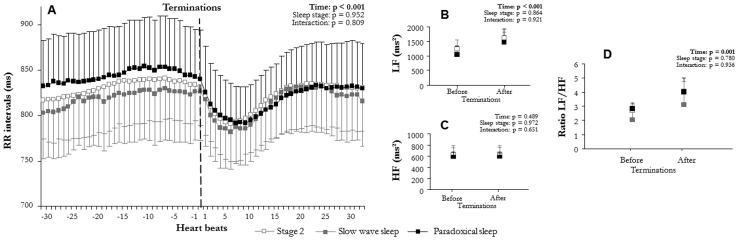
Comparison of autonomic modulation at apnea/hypopnea terminations according to sleep stage: (A) RR intervals (RR), (B) low (LFWV) and (C) high frequency (HFWV) wavelet power, and (D) LFWV/HFWV ratio before and after apnea/hypopnea terminations according to stage 2 sleep, slow wave sleep, and paradoxical sleep (mean ± SEM).An overall effect on RR intervals, LFWV, and LFWV/HFWV ratio appeared between before and after the apnea/hypopnea terminations. Apneas/hypopneas induced a sympathetic-dependent RR decrease, which was not modulated by sleep stage.